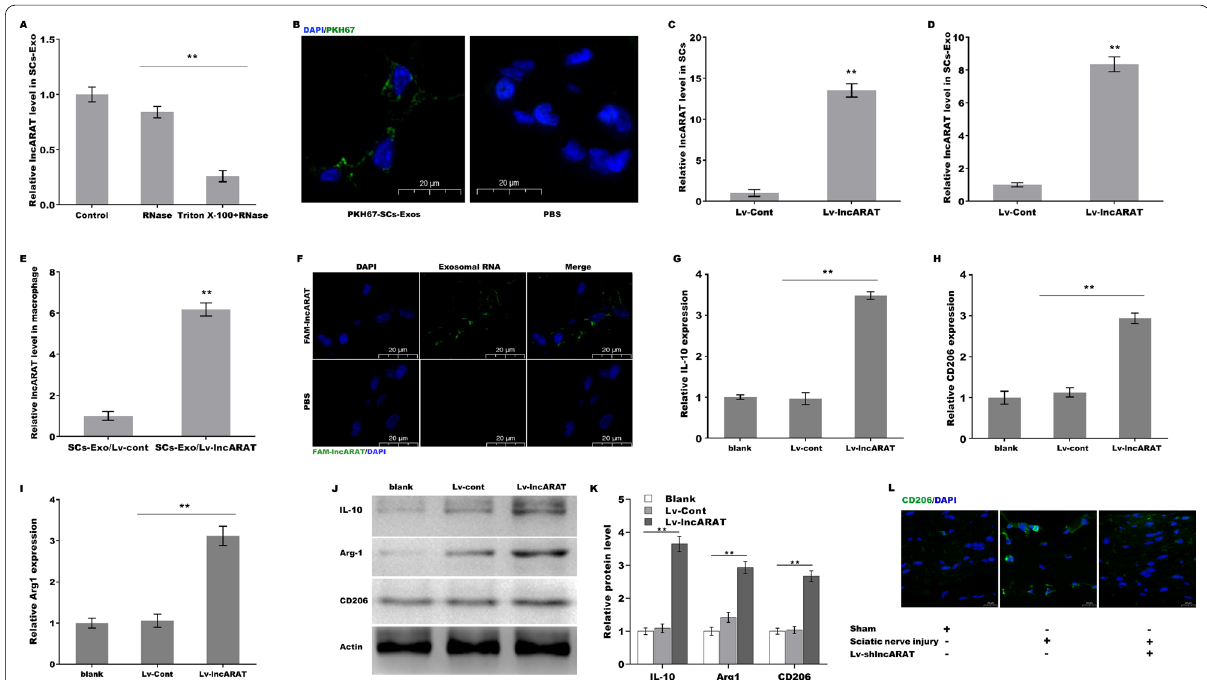
Fig. 4 LncARAT is transferred from SCs to macrophages via SCs-Exo. A qRT-PCR analysis of lncARAT expression in SCs-Exo after RNase treatment in the presence or absence of Triton X-100. B Fluorescence microscopy analysis of U937 macrophages treated with PKH67 (green)-labeled SCs-Exo. PBS served as a negative control. Scale bar, 20 µm. qRT-PCR analysis of lncARAT expression in SCs ( C ) and SCs-Exo ( D ) after lncARAT overexpression. E qRT-PCR analysis of lncARAT expression in U937 macrophages treated with SCs-Exo/Lv-cont or SCs-Exo/Lv-lncARAT. F Fluorescence microscopy analysis of U937 macrophages treated with SCs-Exo/FAM-lncARAT. Scale bar, 20 µm. G – I qRT-PCR analysis of IL-10, CD206, and Arg1 expression in U937 macrophages after treatment with Lv-cont or Lv-lncARAT for 48 h. J and K Western blot and quantitative analysis of IL-10, CD206, and Arg1 expression in U937 macrophages after treatment with Lv-cont or Lv-lncARAT for 48 h. L IF assay of CD206 expression in cross sections of sciatic nerves at 4 dpi from sham rats or rats with sciatic nerve injury after Lv-lncARAT knockdown. Scale bar, 100 µm. * p < 0.05. ** p <